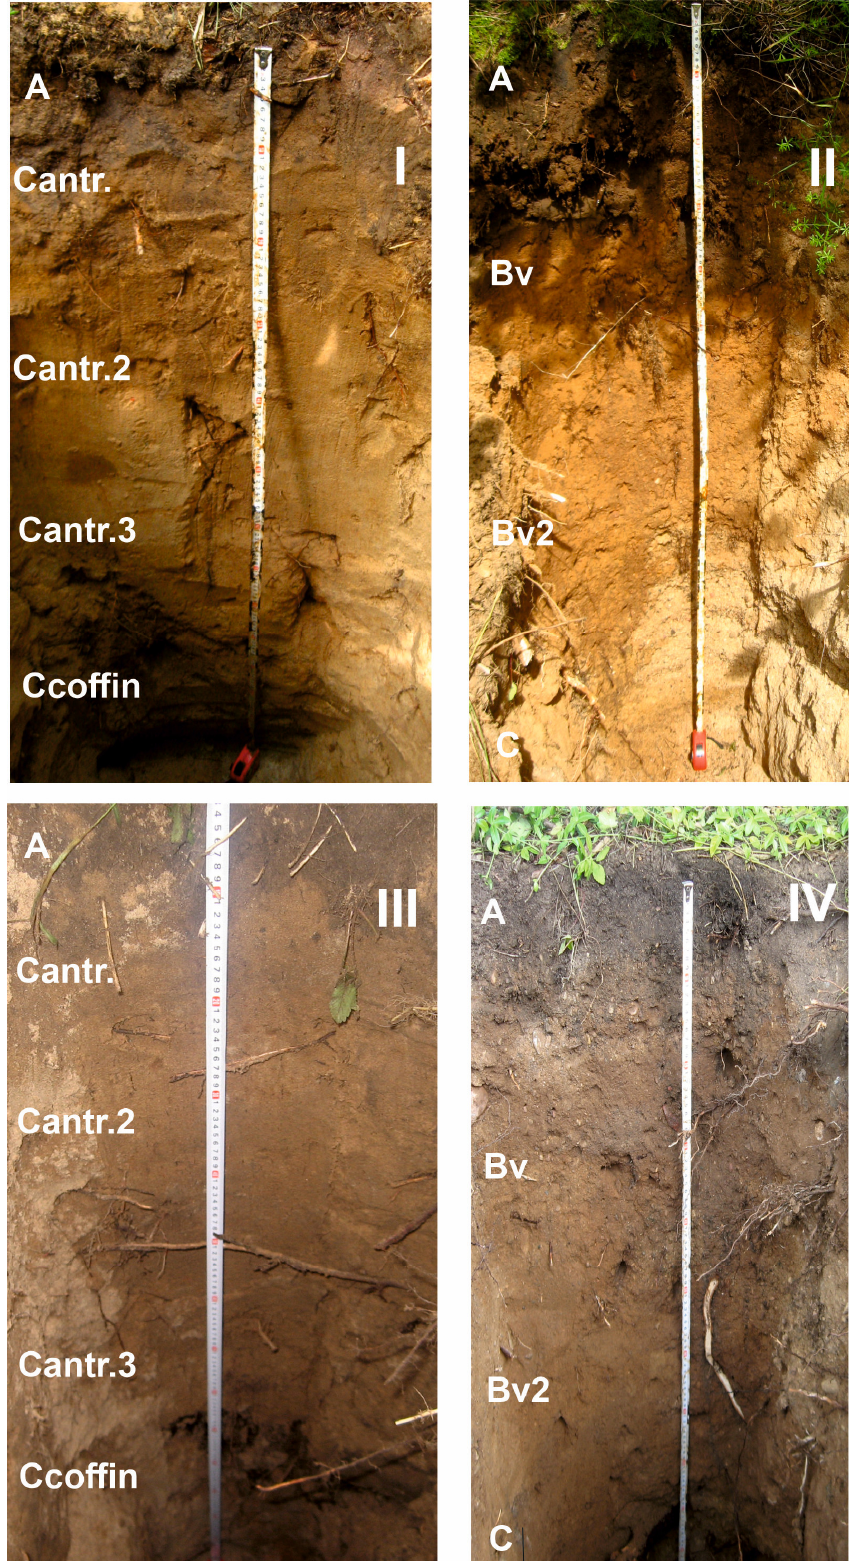
Figure 4. Soil profiles: ( I )—Burial Necrosol Rudówka Mała; ( II )—Unburial cemetery soil Brunic Arenosol Rudówka Mała; ( III )—Burial Necrosol Szymonka; and ( IV )—Unburial cemetery soil Szymonka.